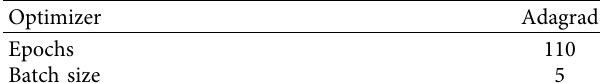
Table 8: The DBN